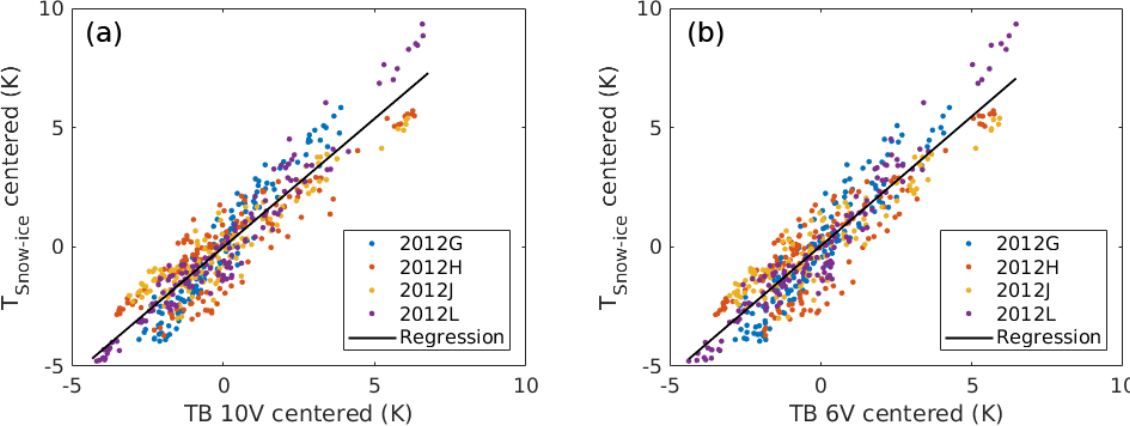
Figure 6. Centred T Snow − Ice expressed as a function of the centred TBs at 10V (a) and 6V (b) . Data from the IMBs are in different colours depending on the buoy, and the linear regression is the solid black line.